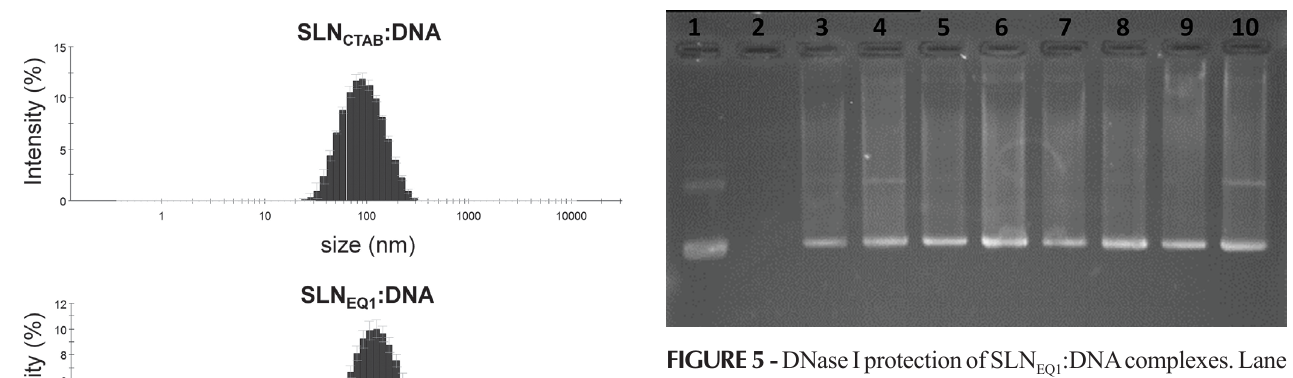
FIGURE 5 - DNase I protection of SLN